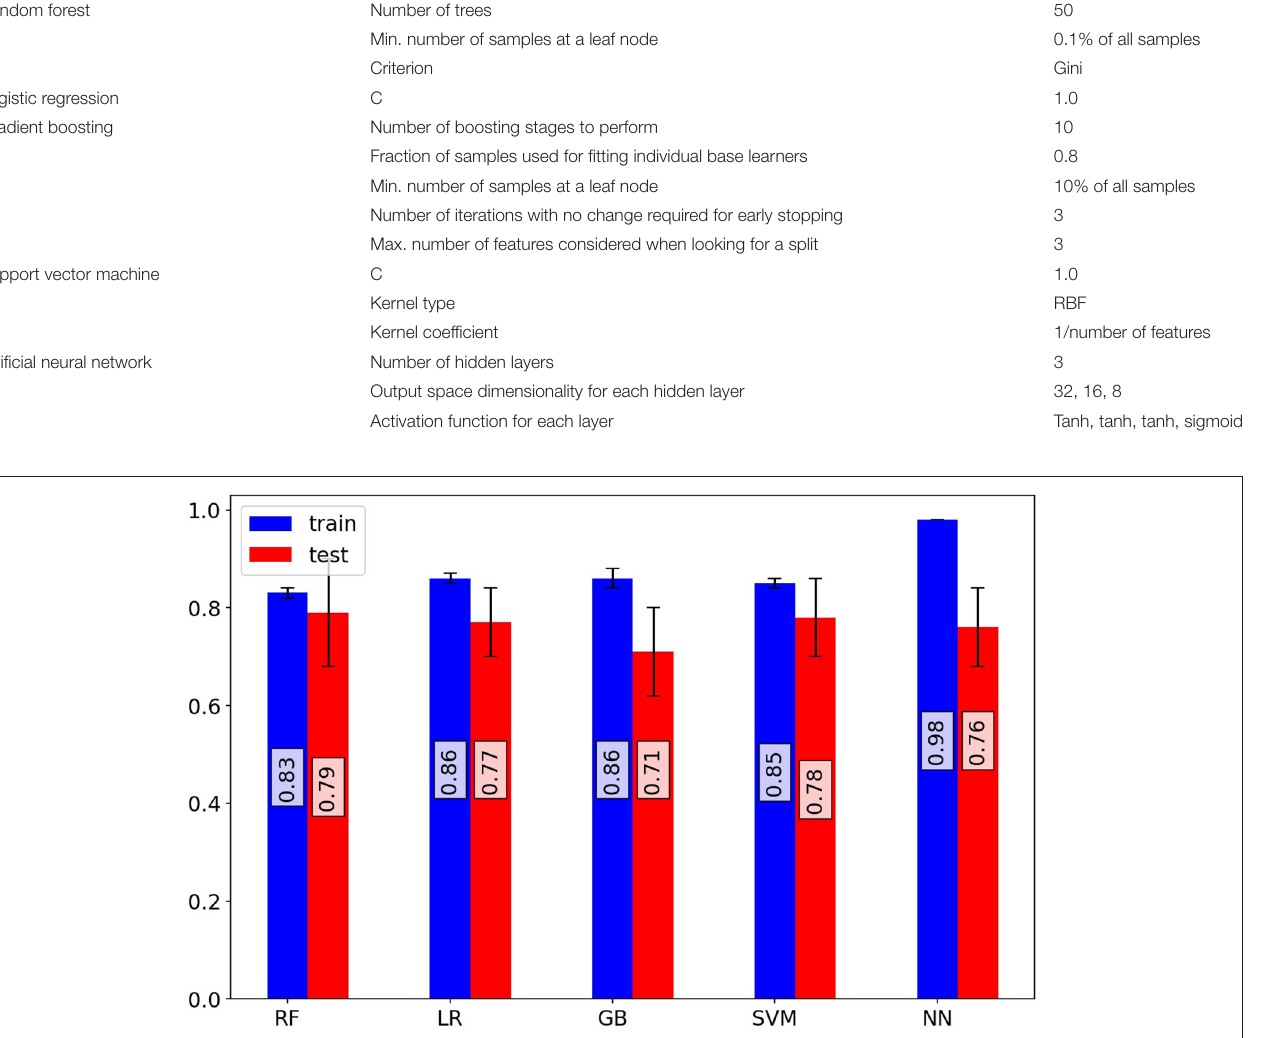
FIGURE 1 | Investigation of model performance. Mean area under the receiver operating characteristic curve (ROC-AUC) of random forest, logistic regression, gradient boosting classifier, support vector machine classifier, and artificial neural network models for training and test sets of cross-validation iterations. The random forest model shows superior performance on validation sets. The random forest model predicts patient outcomes with a 70% sensitivity and 75%